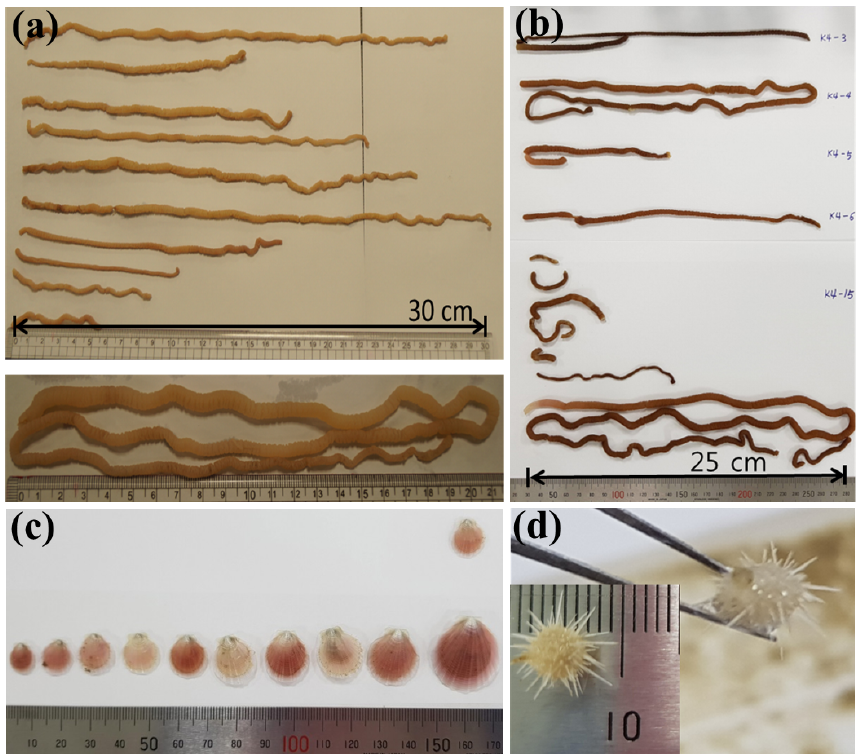
Figure 3. (a) Worm specimens collected at Stations K1 and K3 and (b) at Station K4. (c) Scallops and (d) a sea urchin were collected at Station